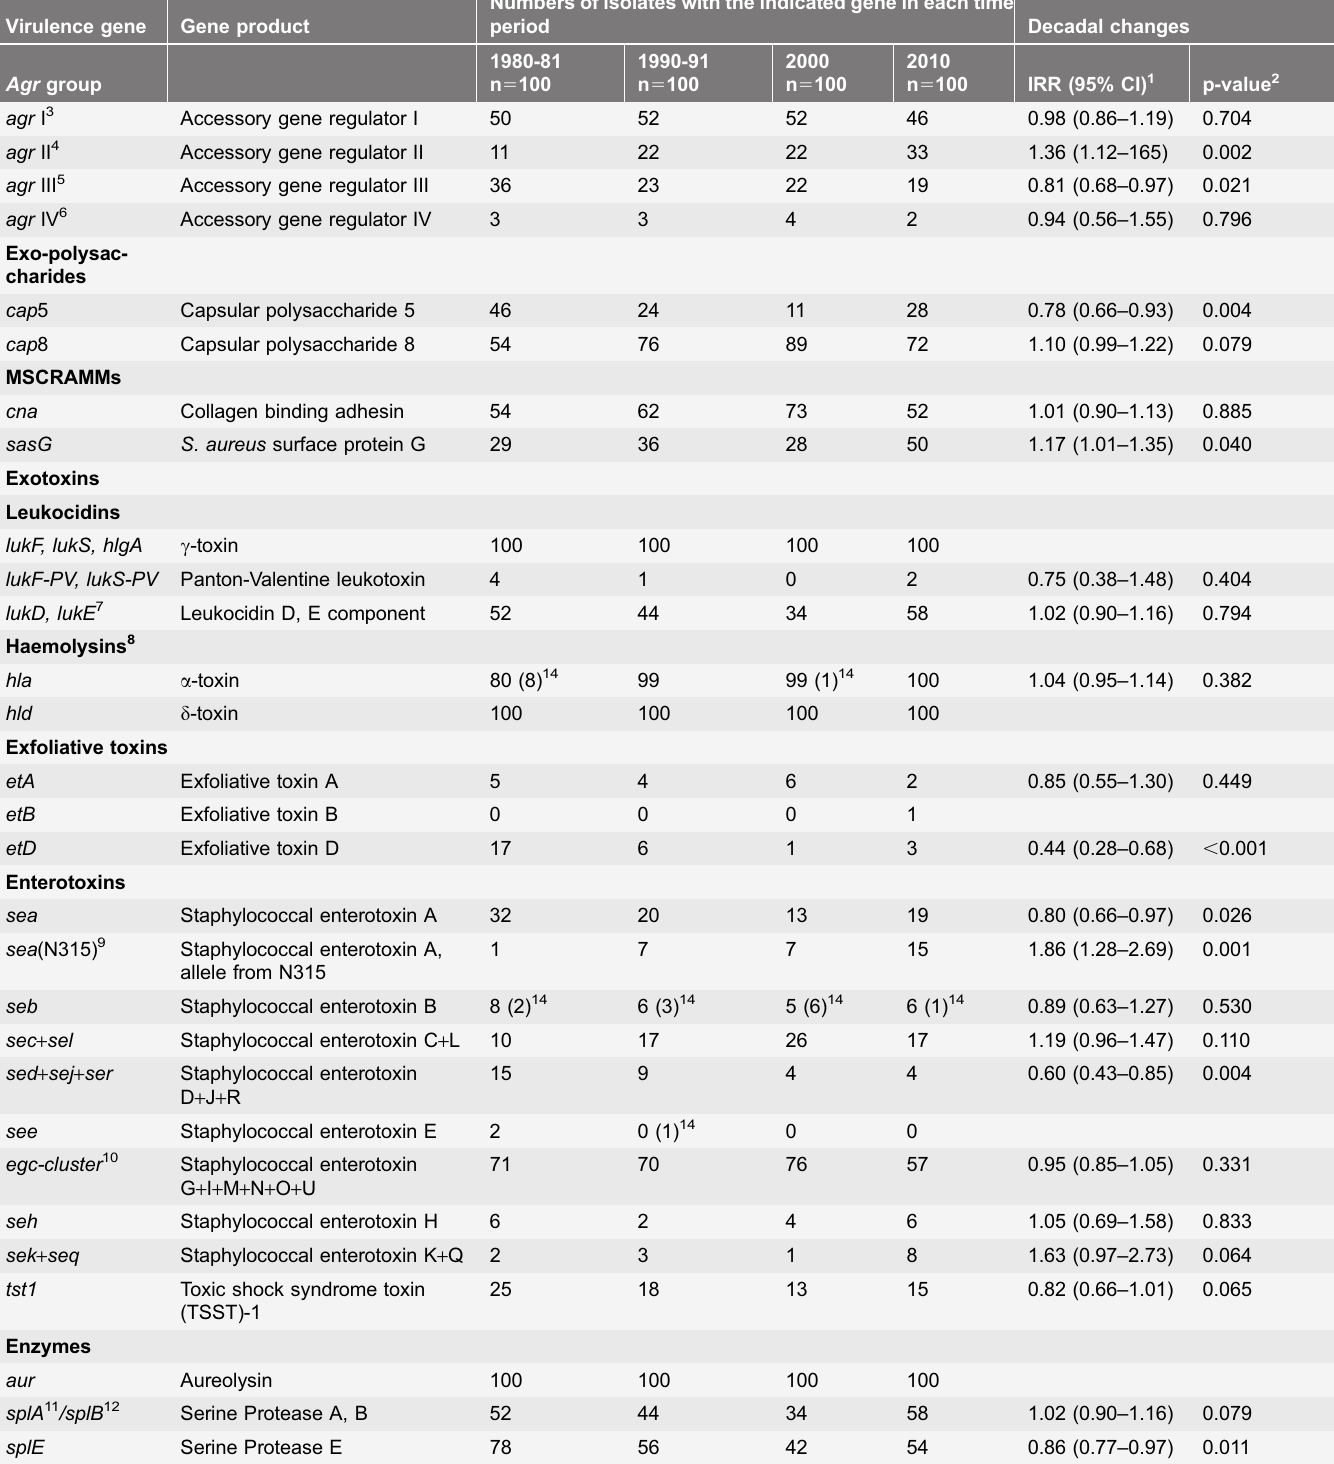
Table 3. Distribution of agr groups (alleles) and presence of virulence genes among SAB isolates from four different time